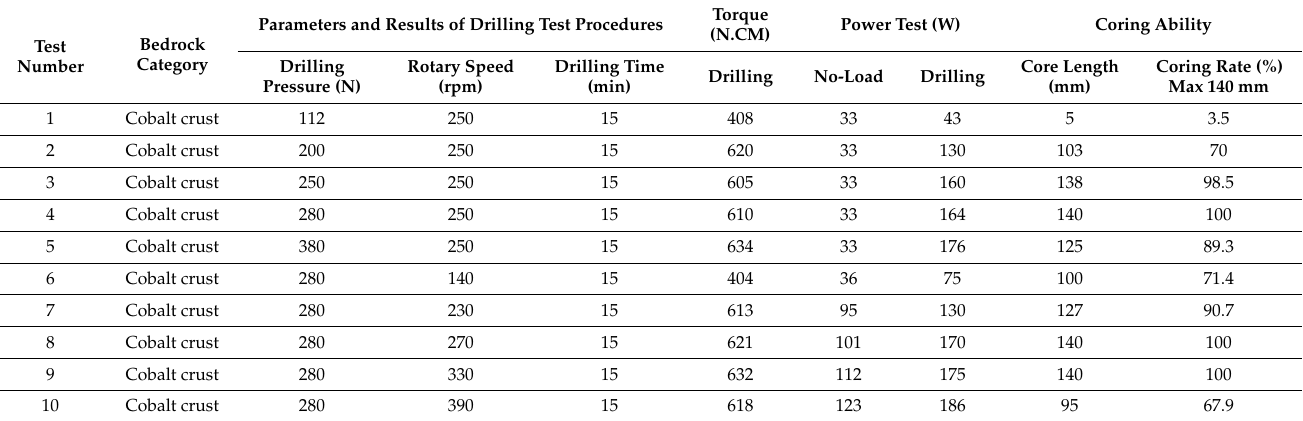
Table 4. Parameters used in the drilling experiment of A2 bit.